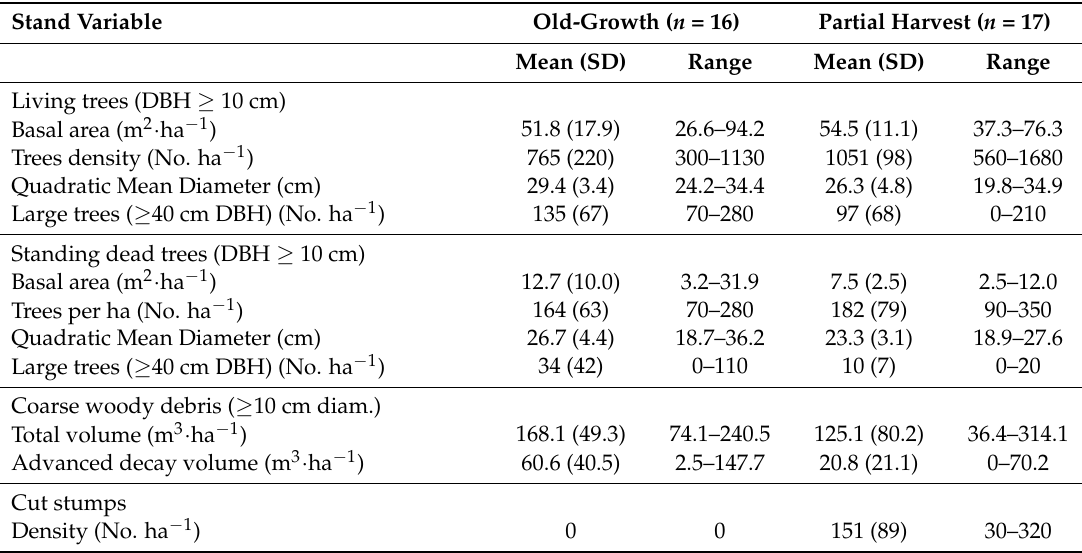
Table 1. Means (with standard deviation: SD) and ranges of stand structural variables for old-growth and partially harvested white-cedar stands ( n = number of